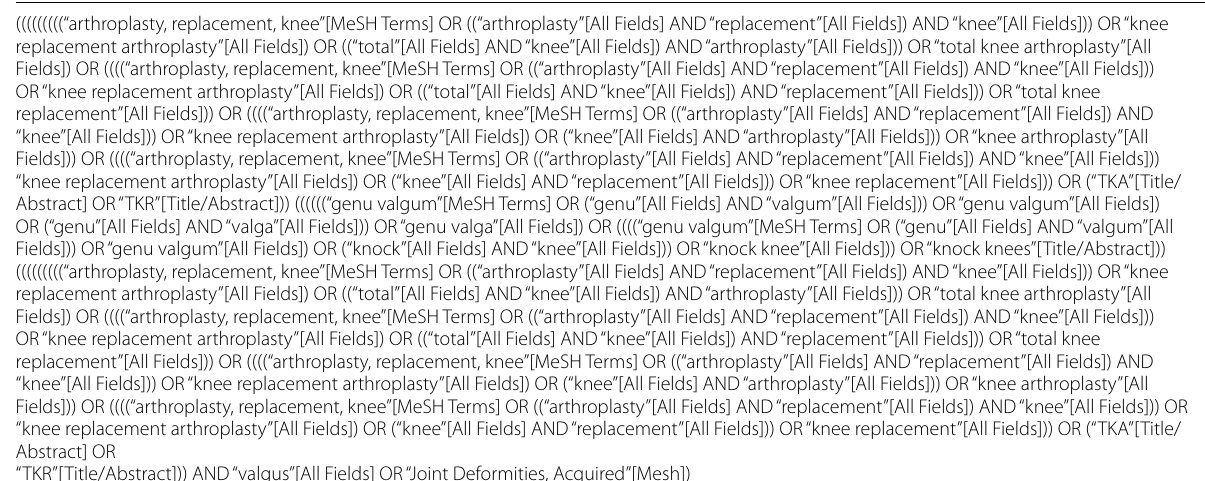
Table 1 PubMed search strategy, October